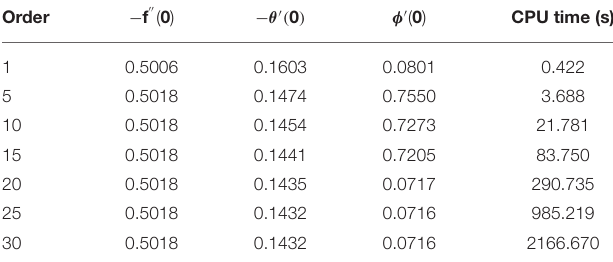
TABLE 1 | Order of approximations of